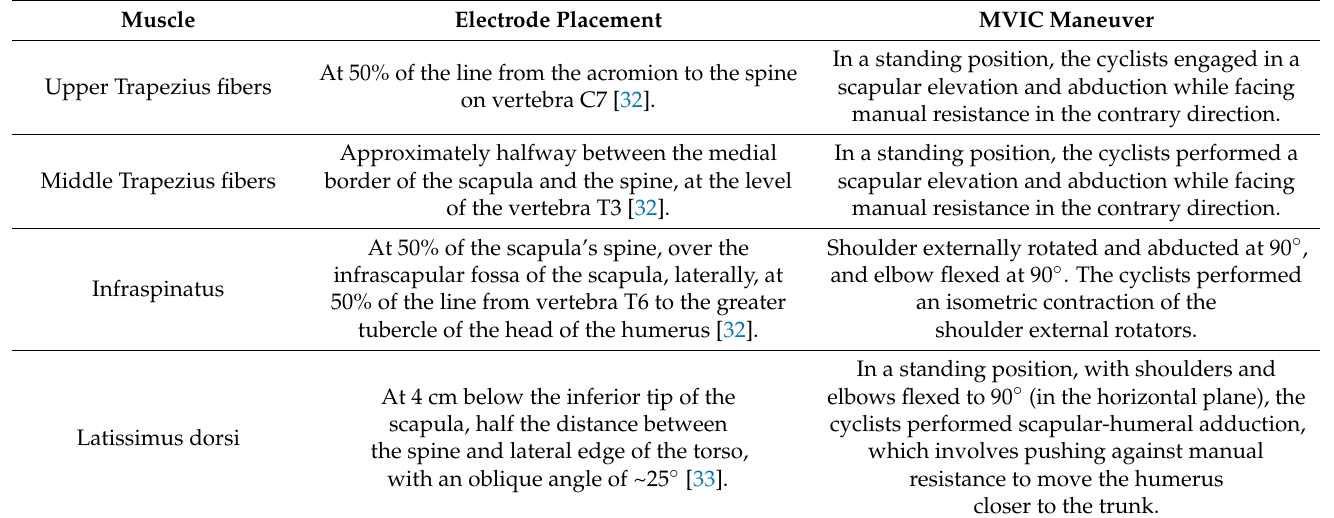
Table 1. Surface electrode placement and maximal isometric voluntary contraction (MVIC) maneuver